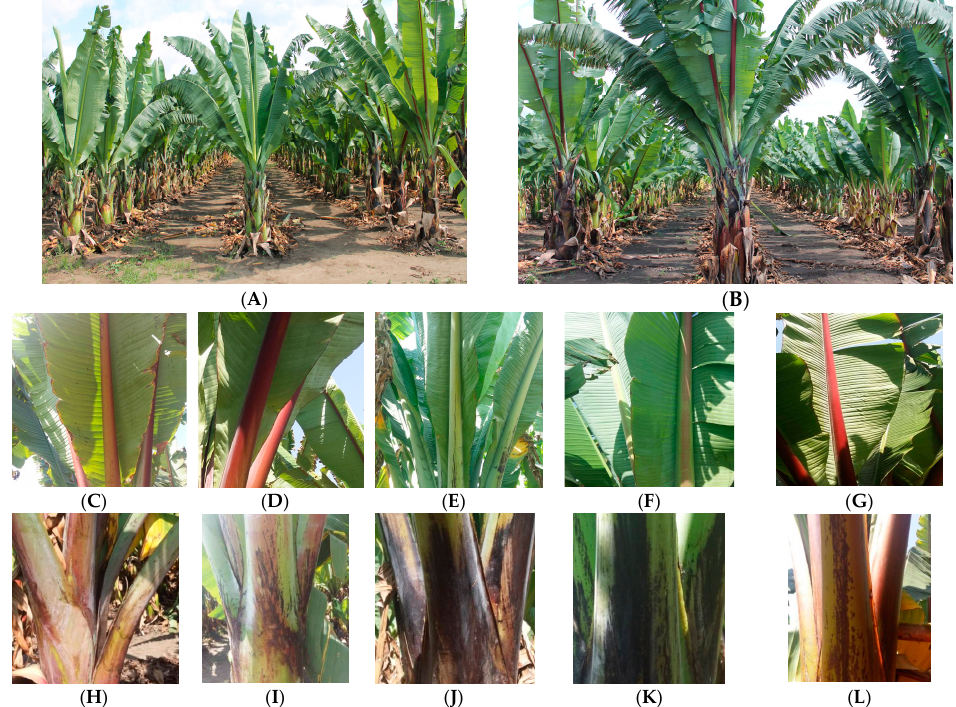
Figure 1. Agro-morphological characterization activity at Areka Agricultural Research Center. ( A and B ) Typical arrangement of landraces for phenotyping; ( C – G ) Examples of morphological variation in midrib color; ( H – L ) Examples of morphological variation in petiole color.